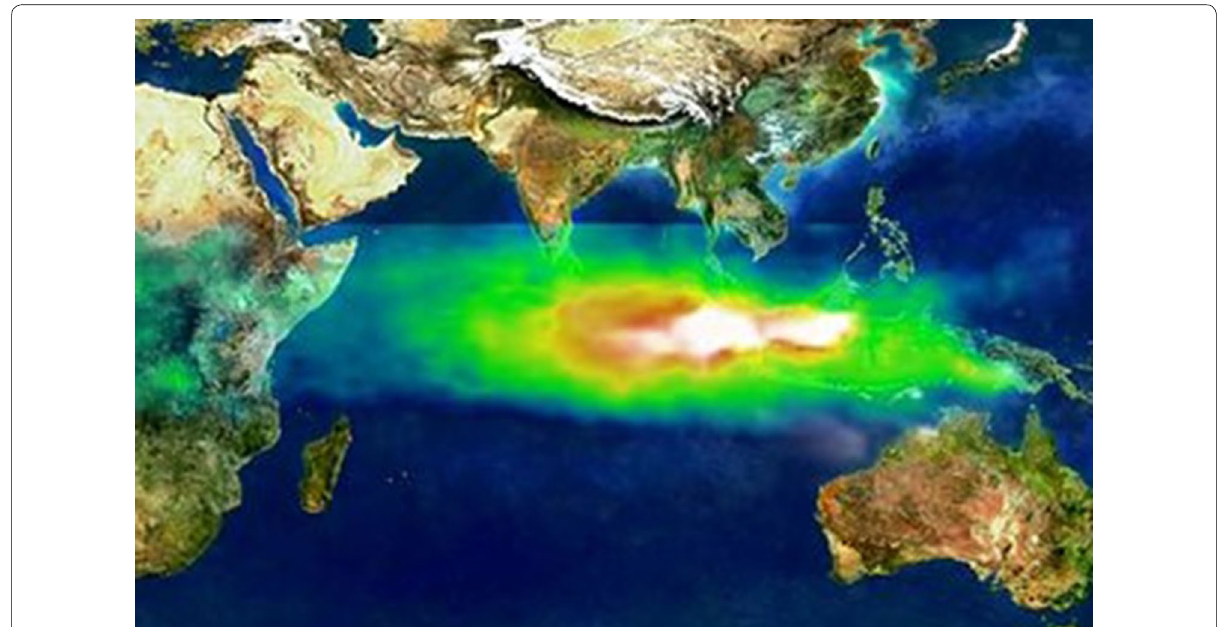
Fig. 2 Smog flow from Sumatra to Malaysia in